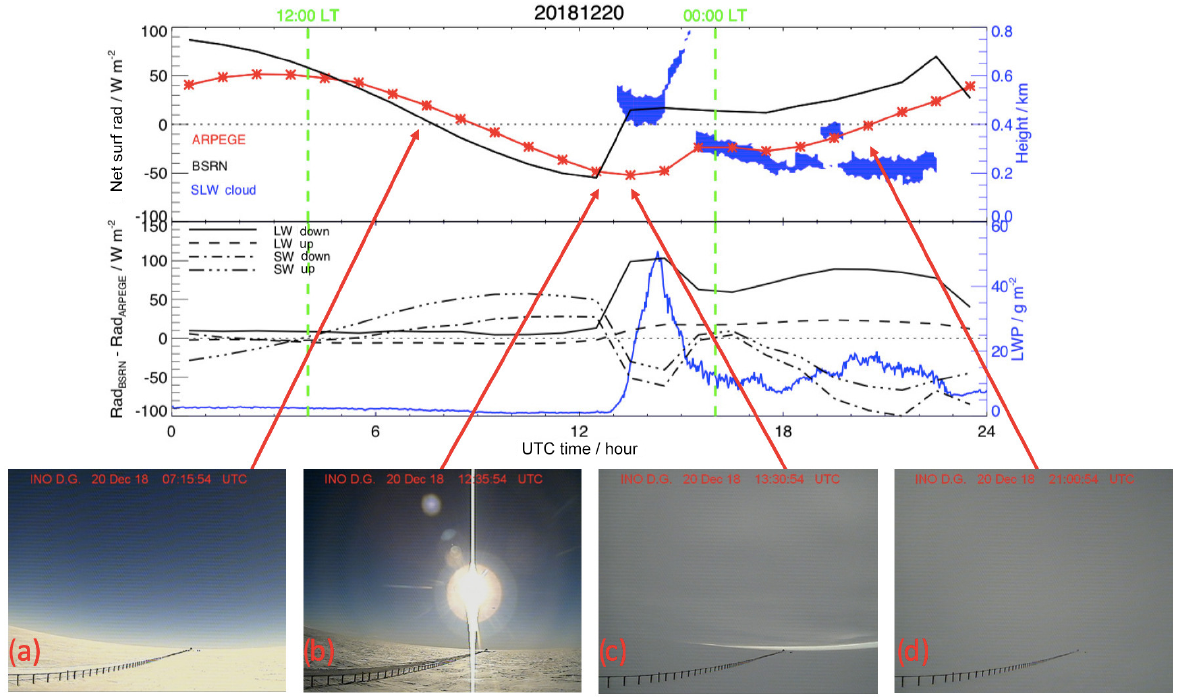
Figure 16. Same as Fig. 15 but for 20 December 2018, whilst the four webcam images were selected at (a) 07:15 and (b) 12:35UTC (clear sky), (c) 13:30, and (d) 21:00UTC (SLW cloud).